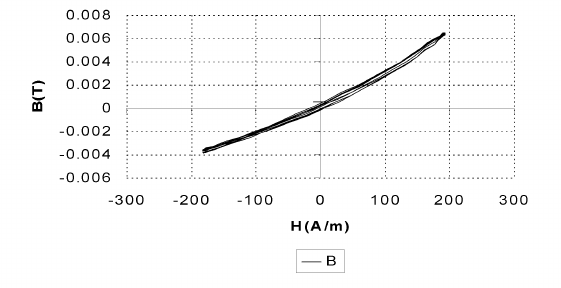
Figure 12: BH Curve derived from FCL operation under nominal load conditions